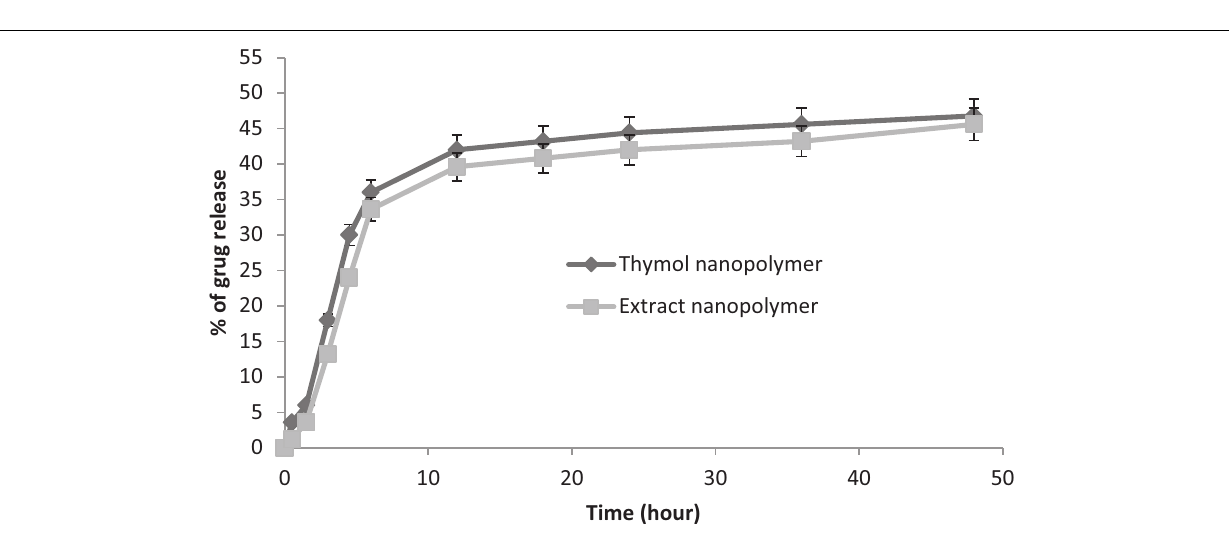
FIGURE 8 | In vitro release of thymol and extract-loaded nanopolymer in distilled water.